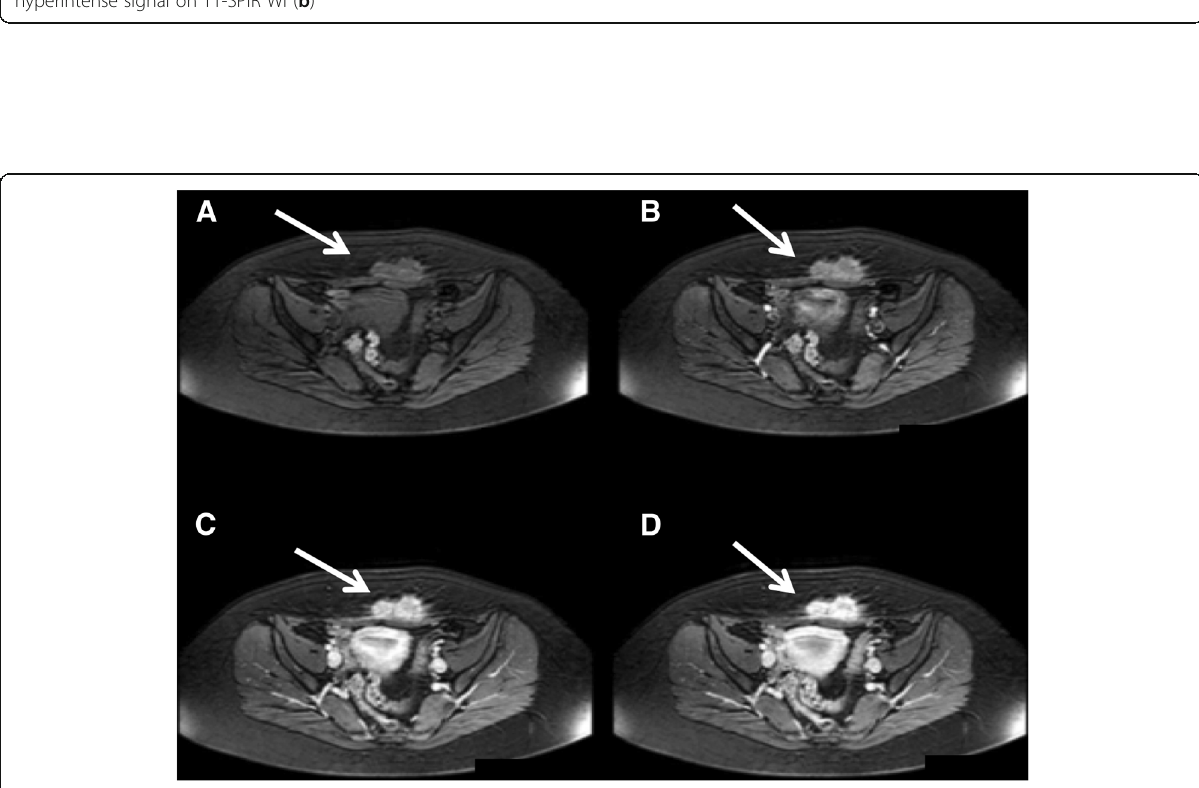
Fig. 12 (Same patient of Fig. 11). Abdominal wall endometriosis (white arrows) showed progressive and late contrast enhancement on T1-THRIVE WI ( b , arterial, c , portal and d , venous phases). a , T1-THRIVE WI before contrast